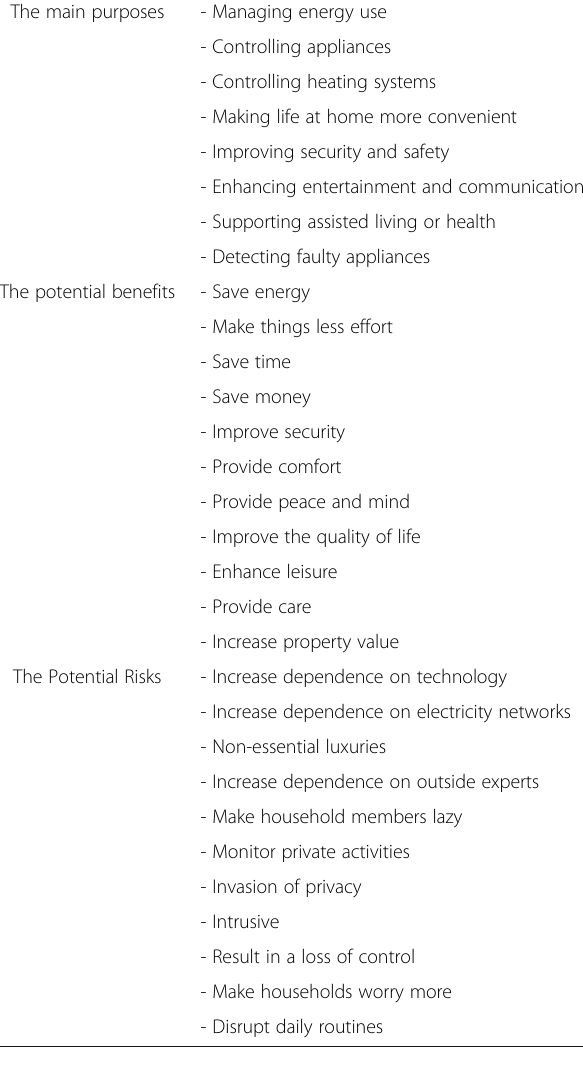
Table 5 The main features of smart home technologies [36] The main purposes